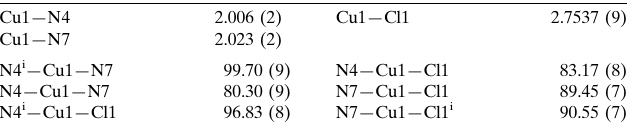
Selected geometric parameters (A˚ , (cid:4) ).